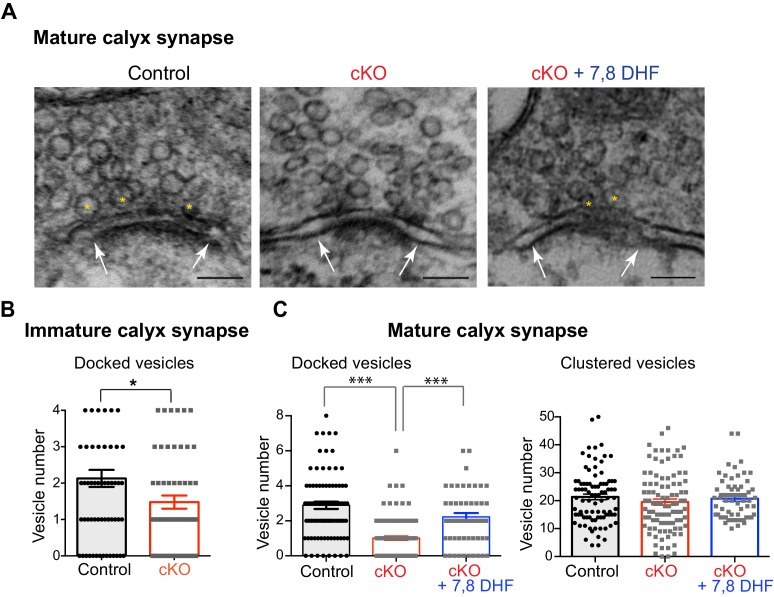
Loss of oligodendroglial BDNF reduces the number of docked vesicles at active zones of the calyx terminals.(A) EM images of the calyx terminal in the MNTB in control (left) and cKO (middle), and 7,8-DHF treatment on cKO mice (right) at P20. Higher magnification of a presynaptic terminal showed the active zones and synaptic vesicles. The active zones are the dense and dark sites in contact with the MNTB cell membrane (white arrows). Yellow asterisks indicate the docked vesicles within 10 nm of the active zone. The clustered vesicles were located within 200 nm of the active zones. Scale bars, 100 nm. (B) Summary of the number of docked vesicles in immature calyx terminals from control (black) and cKO (red) mice at P10. (C) Summary of the number of docked vesicles (left) and clustered vesicles (right) at active zones for mature calyx terminals from control (black), cKO (red), and 7,8-DHF treatment on cKO mice (blue) at P20. Data are shown as the mean ± s.e.m. *p<0.05; ***p<0.001 (unpaired t-test).